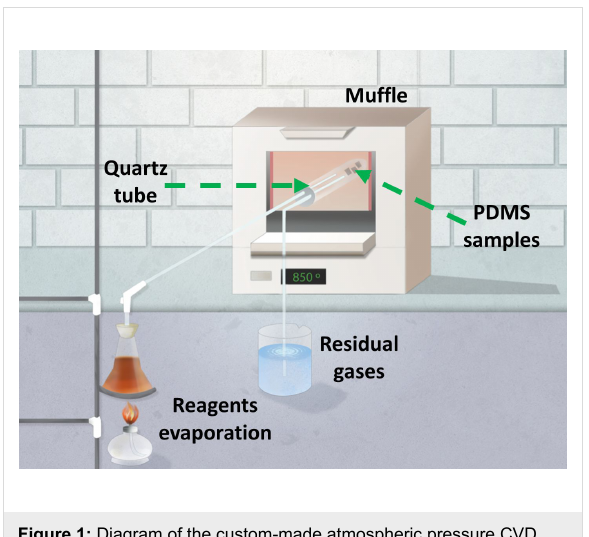
Figure 1: Diagram of the custom-made atmospheric pressure CVD